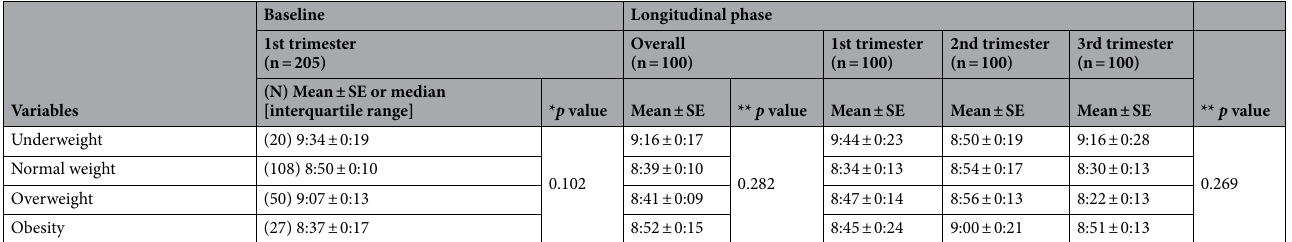
Table 3. Association of social jetlag and sleep patterns with anthropometric variables in the baseline (n = 205) and throughout the trimesters in the longitudinal phase (n = 100). SE standard error; BMI body mass index. * p values calculated by—generalised linear models (GzLM) (mean ± standard deviation) in the baseline. Adjusted to age, marital status, schooling, work (yes or no), gestational age and parity. Sidak post-hoc test, p value < 0.05 was considered significant. ** p values calculated by Generalized Estimating Equation (GEE) (mean ± standard deviation) in the longitudinal phase. Significant results of the models were shown in bold. †Adjusted for age, marital status, schooling, work (yes or no), parity, body mass index and Pittsburgh Sleep Quality Index Global Sleep Quality Score. ‡Adjusted to age, marital status, schooling, work (yes or no), parity and gestational age. ¥ Time is presented in 24-h clock time. Sidak post-hoc test, p value < 0.05 was considered significant. ¢The sequential Sidak’s post-test did not identify any differences between the BMI categories. Total gestational data’s values represent the average of the three trimesters.